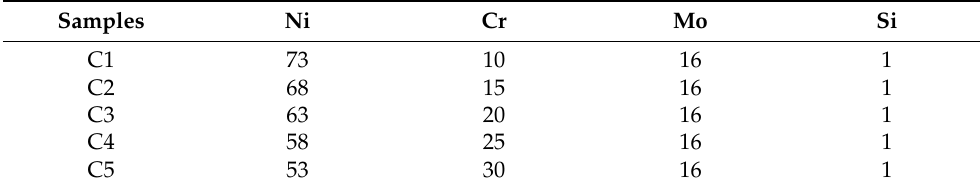
Table 1. Chemical composition of laser-cladding Ni-based powder